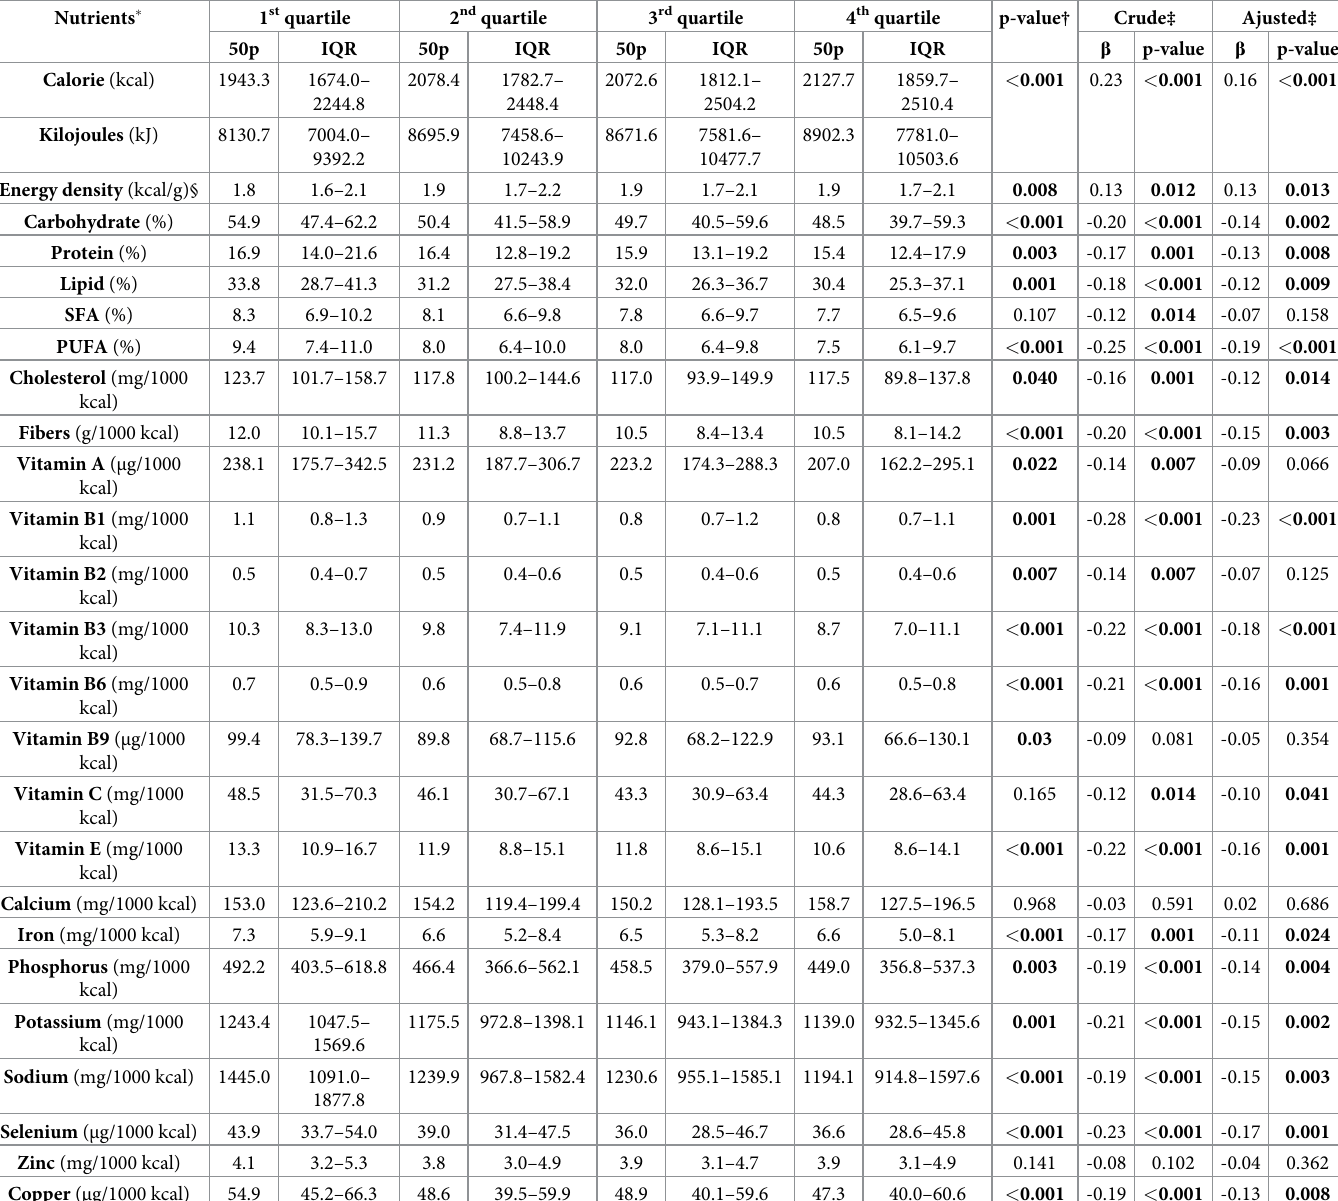
Table 6. Diet’s nutritional profile according to the caloric contribution of the consumption of processed foods by Brazilian